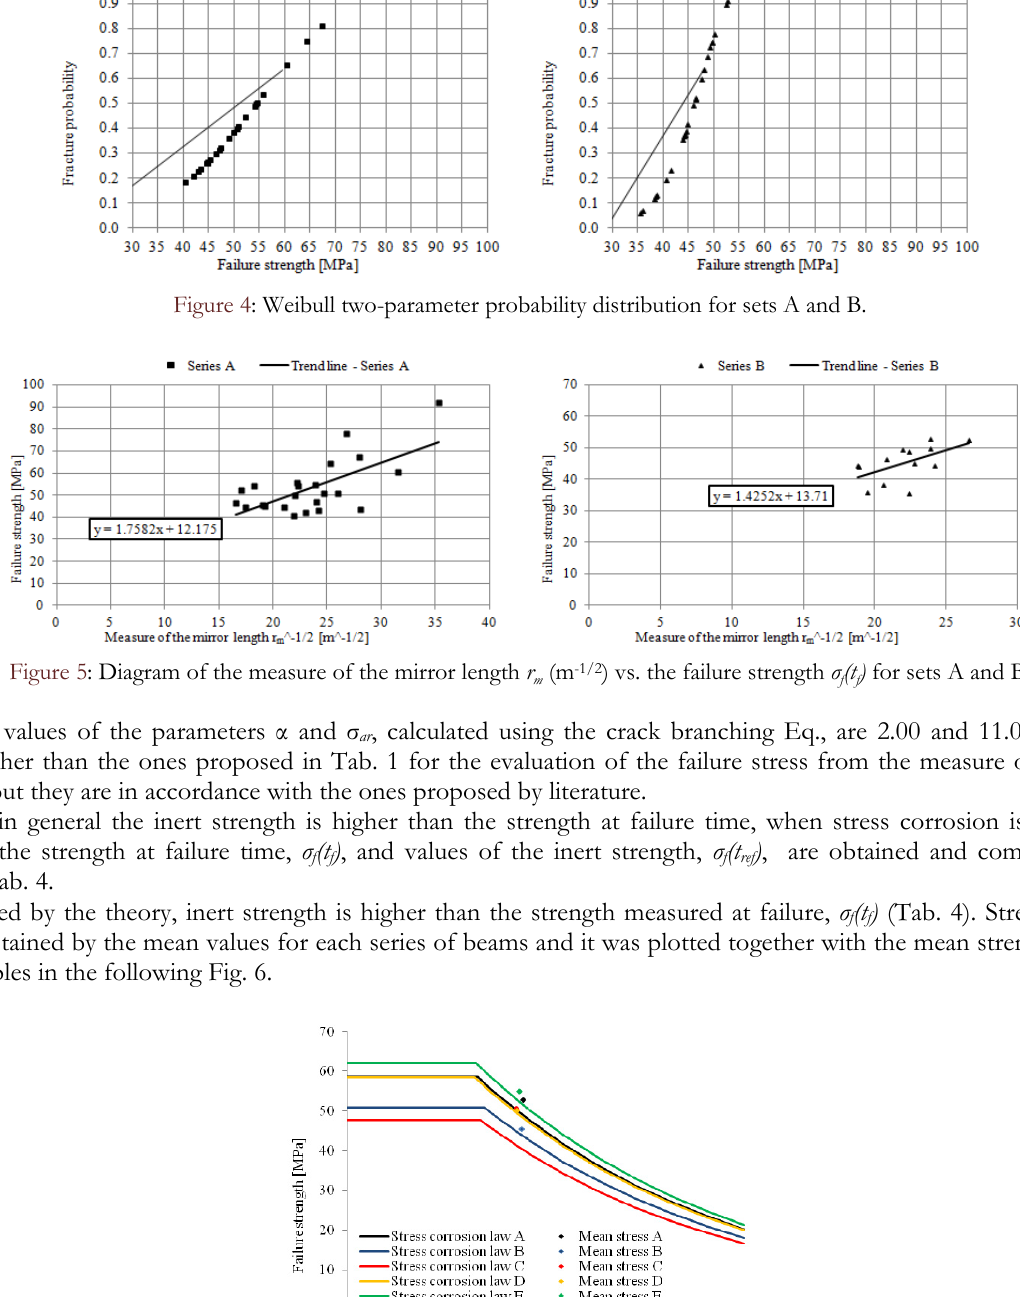
Figure 6: Stress corrosion law for each series of